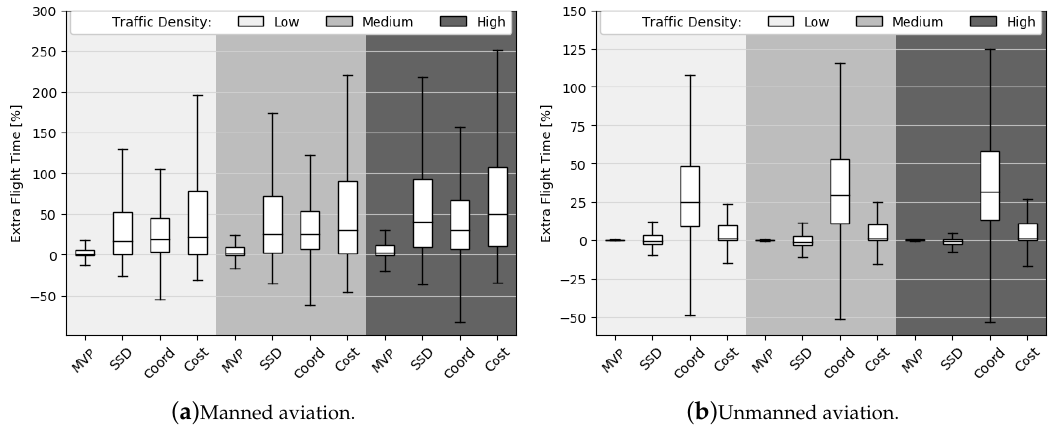
Figure 17. Extra flight time per flight and per CD&R